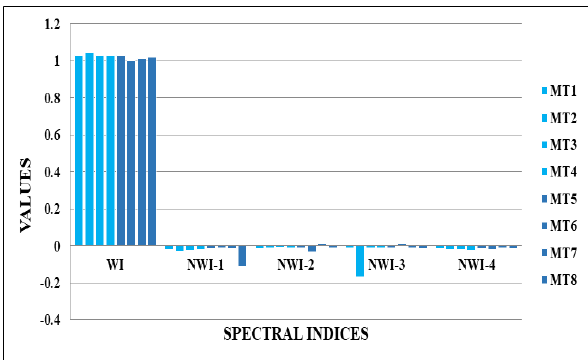
Figure 12.Comparison of different spectral indices for water content in selected mango tree